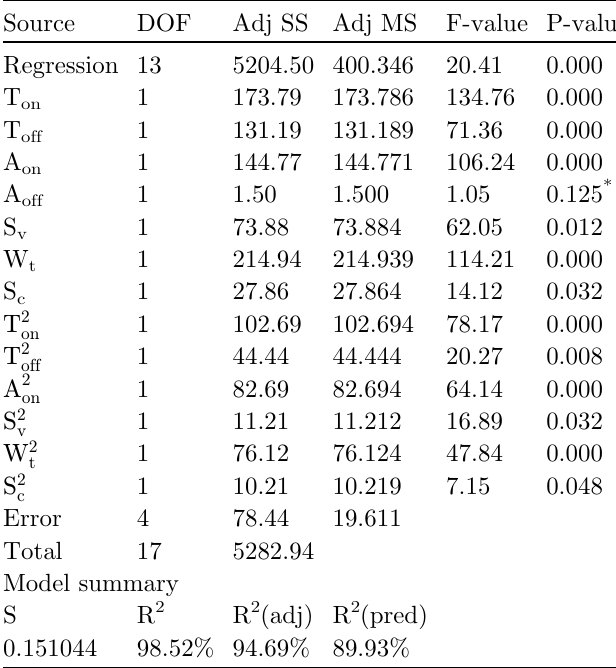
Table 4. ANOVA for corner error.